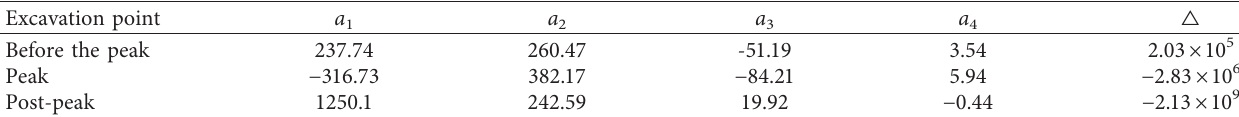
Figure 7: Local energy release rate curve of the pillar. (a) Excavation in front of the peak. (b) Peak excavation. (c) Excavation after the peak. Table 2: determination value of local energy mutation of